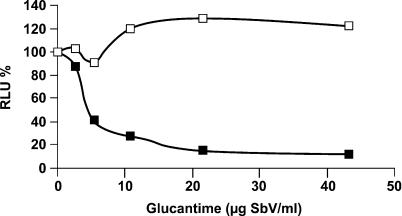
Reversal of Antimony Resistance in Intracellular ACL Strains Using BSOThe glutathione-specific inhibitor BSO (5 mM) abrogated resistance in the Glucantime-resistant strains 439, 670, 827, and 878. Only the result for strain 827 (expressing the firefly luciferase) is shown, which represents an average of two duplicate experiments. Open squares indicate strain 827; filled squares indicate strain 827 and BSO.